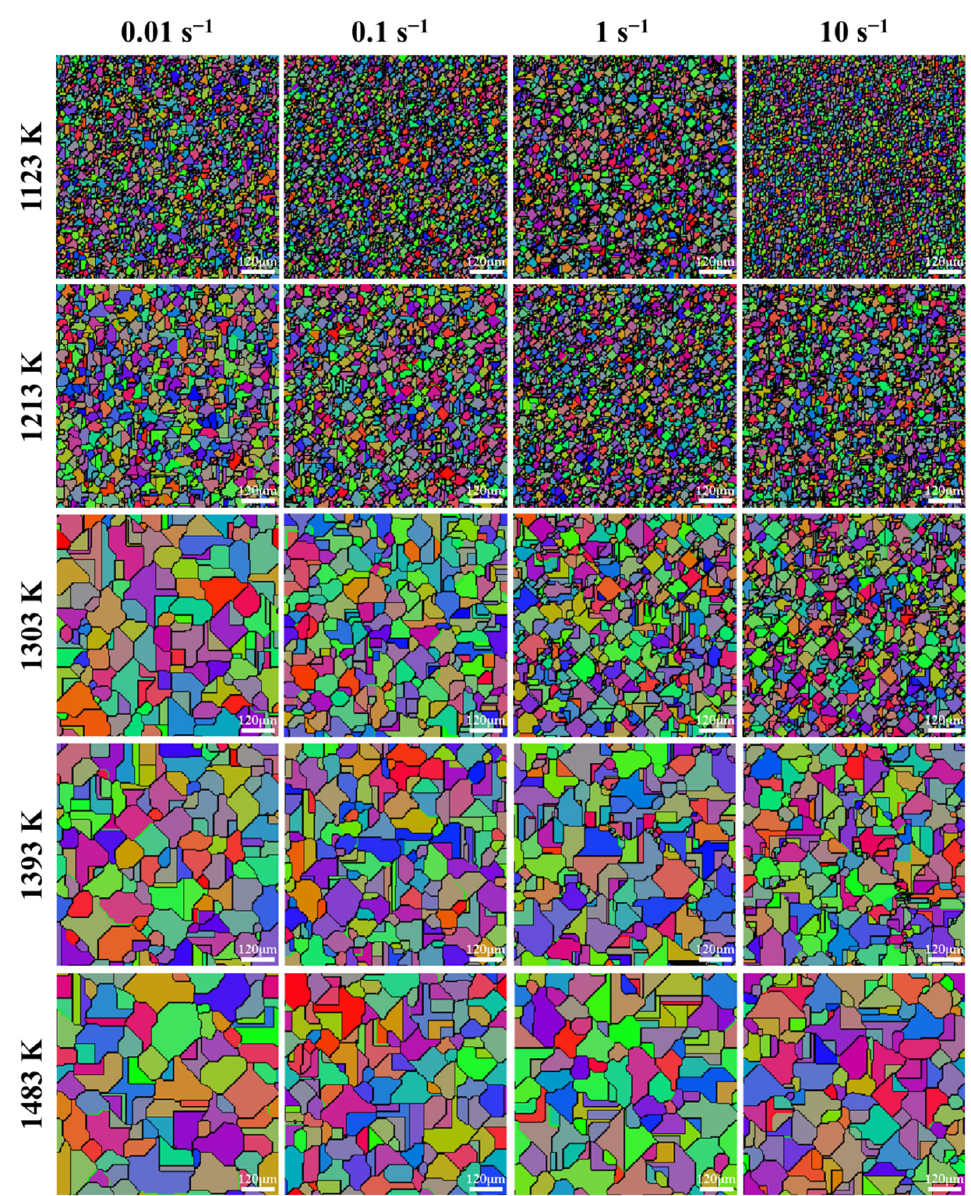
Figure 22. Grain morphology of the specimens compressed to a fixed true strain of 0.916 under temperatures of 1123–1483 K and strain rates of 0.01–10 s − 1 .